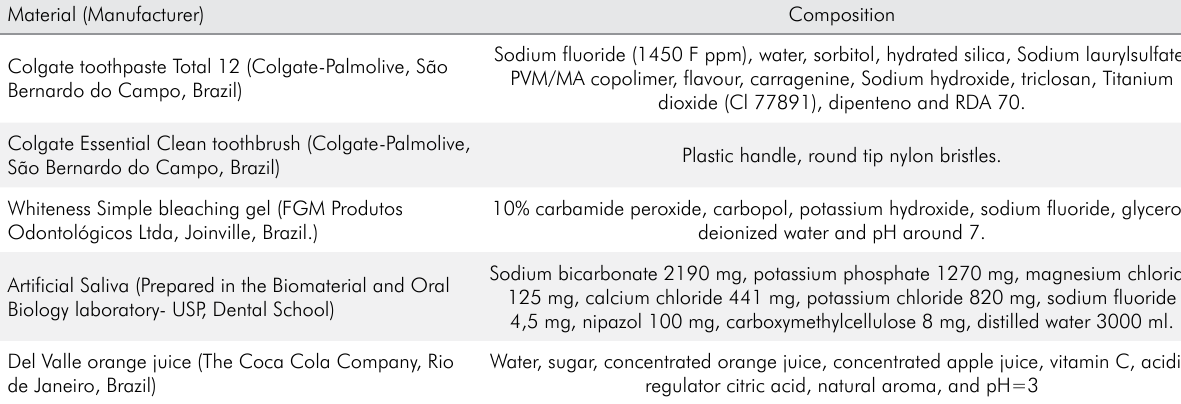
Table 1. Materials, commercial names, and composition, according to the manufacturers. Material